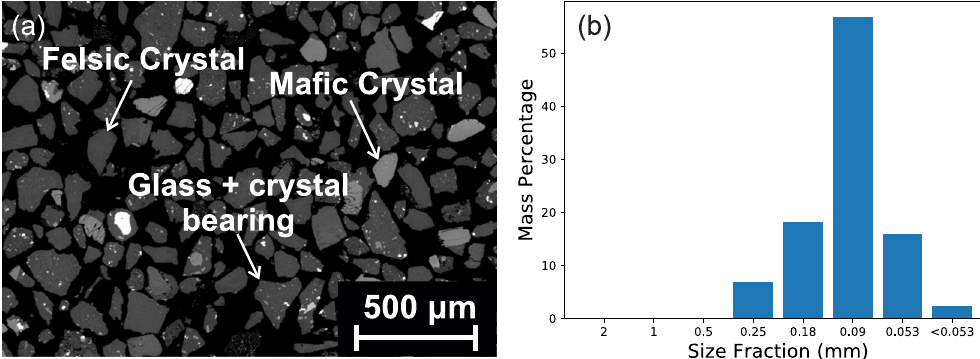
Figure 5. Sample ash collected from Santiaguito. ( a ) BSE SEM image of the ash sample. ( b ) Particle size distribution of the ash collected from Santiaguito on 20 th January 2018. The size fractions were sorted by dry- sieving the